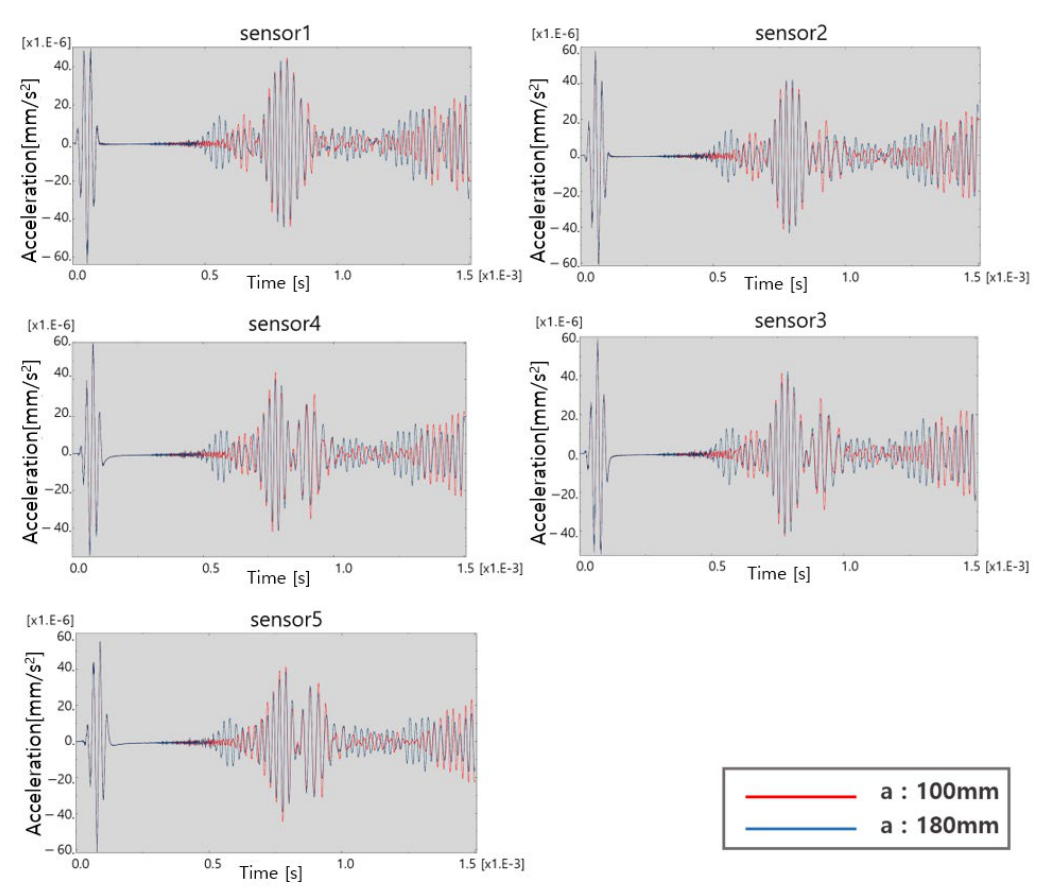
Figure 3. Measured results at each sensor